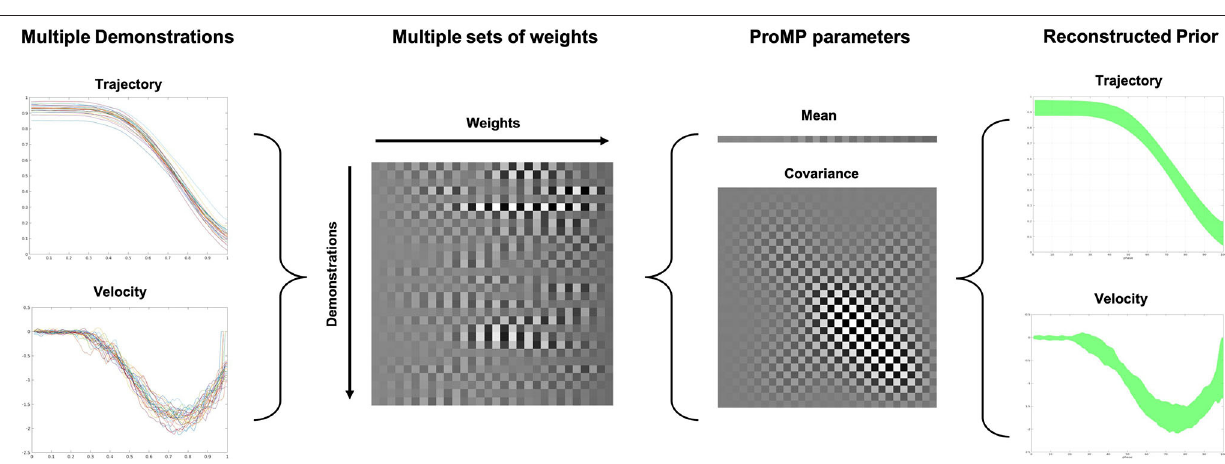
FIGURE 3 | The rationale of Probabilistic Movement Primitive (ProMP) skill modeling approach. The multiple demonstrations are encoded into a number of weights. Then the Gaussian process regression is applied in the weight space, which further encoded the skill. The distribution of the trajectories can be recovered using Equation (3). The grayscale in the chessboard-like representation of the ProMP parameters indicates the normalized value for each basis. The white block means a high value, whereas the black block means